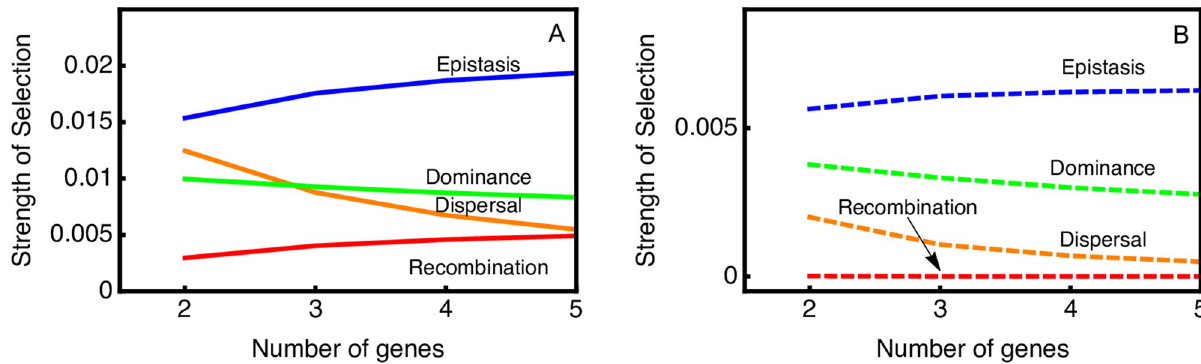
Fig 3. Strength of selection on different modifiers as measured by λ − 1. Parameter values for the ancestral population are S = 0.1, M = 0.05, R = 0.5; θ = 0; ϕ = 0. Panel (A) shows the strength of selection of the maximum effect for each parameter (for dominance and epistasis we use a parameter value of 10, for migration and recombination we use a value of 0). Panel (B) shows the effect when the parameters have a modest value (for dominance and epistasis we use a parameter value of 1.5, for migration and recombination we use a value of half the resident population value).